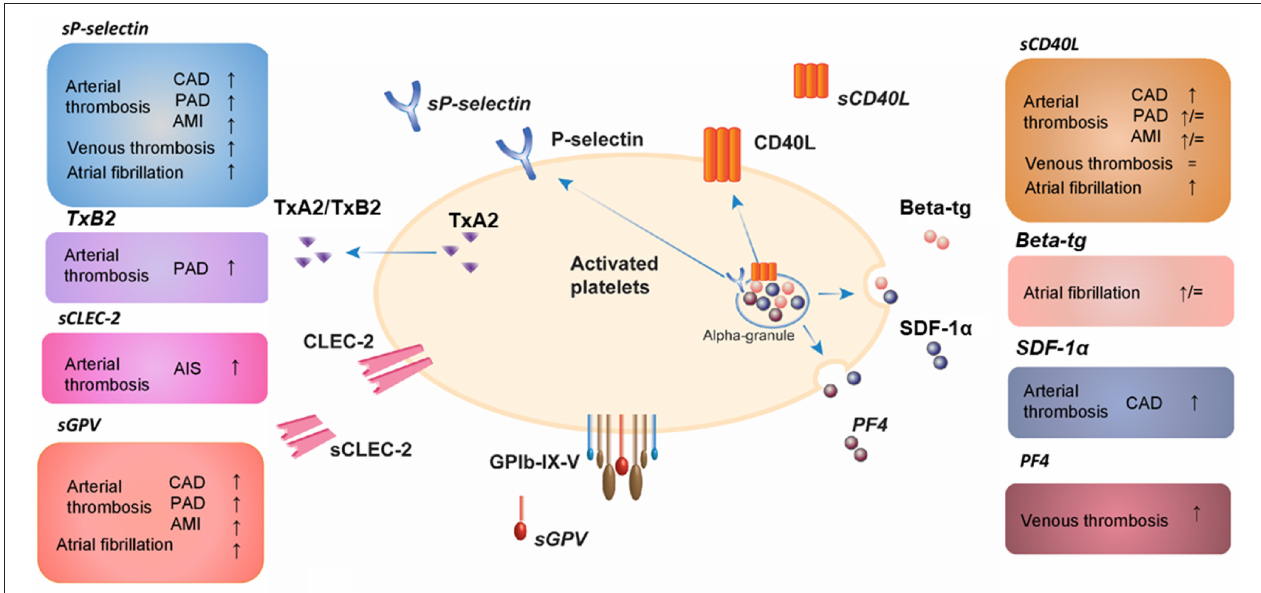
FIGURE 2 | Platelet released activation biomarkers in arterial and venous cardiovascular diseases determined by ELISA-based tests. AIS, acute ischemic stroke; AMI, acute myocardial infarction; beta-tg, β -thromboglobulin; CAD, coronary artery disease; CD40L, CD40 ligand; CLEC-2, C-type lectin-like receptor 2; GP, glycoprotein; PF4, platelet factor 4; SDF-1 α , stromal cell-derived factor-1 α ; TxA2, thromboxane A2; TxB2, thromboxane B2; PAD, peripheral artery disease; s, soluble; ↑ , increased compared to healthy controls; ↓ , decreased compared to healthy controls; = , unchanged compared to healthy